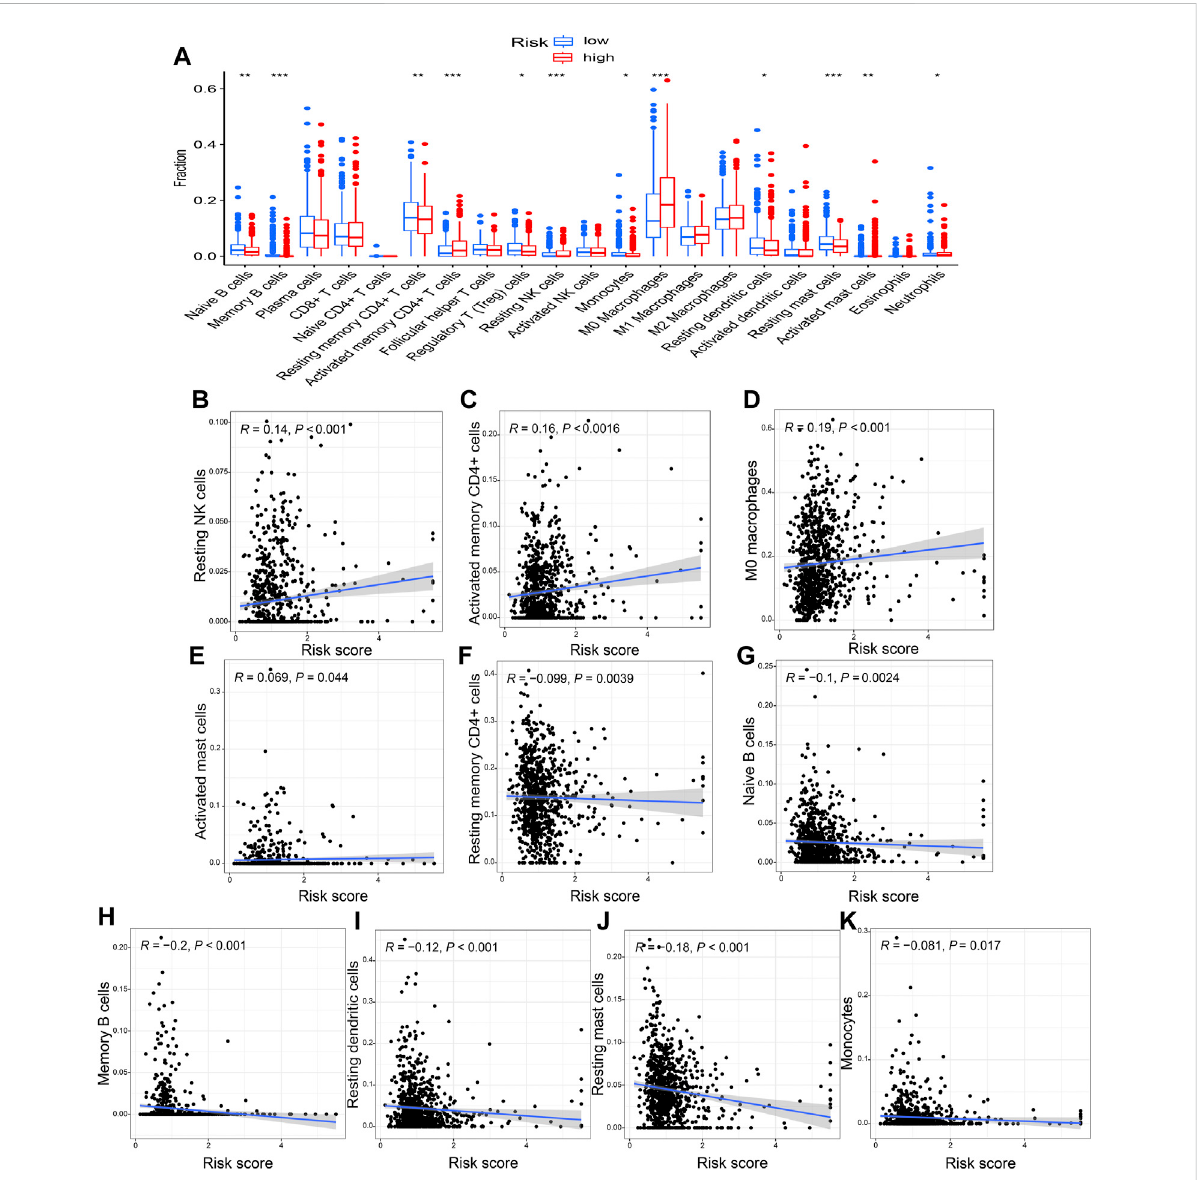
FIGURE 9 The correlation of risk score with immune in fi ltration (A) The different immune-in fi ltration pro fi les between the two risk groups. A positive correlation withtheriskscorewasseen for (B) resting NKcells, (C) activated memory CD4 + Tcells, (D) M 0 macrophages,and (E) activated mastcells. Whereas (F) resting memory CD4 + T cells, (G) naïve B cells, (H) memory B cells, (I) resting dendritic cells, (J) resting mast cells, and (K) monocytes were negatively correlated with the risk score. * p < 0.05; ** p < 0.01; *** p <